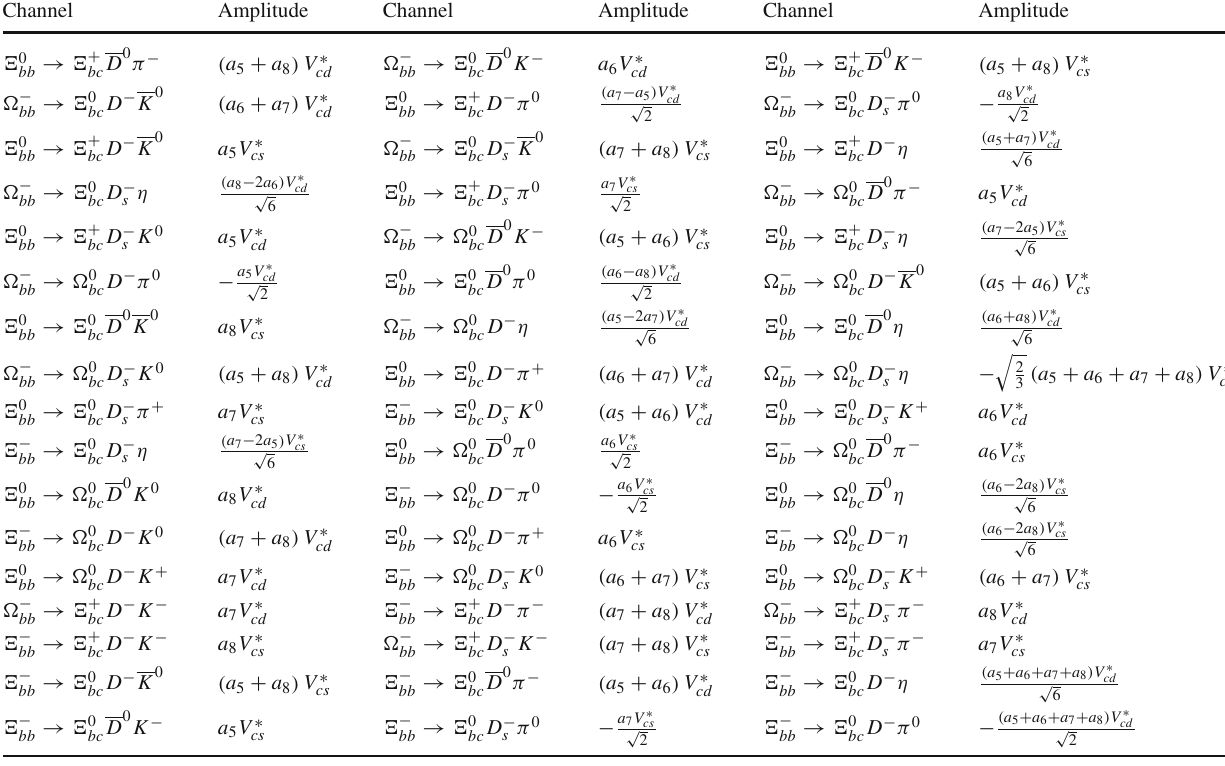
Table 16 Doubly bottom baryon decays into a bcq , an anti-charmed meson and a light meson Channel Amplitude Channel Amplitude Channel